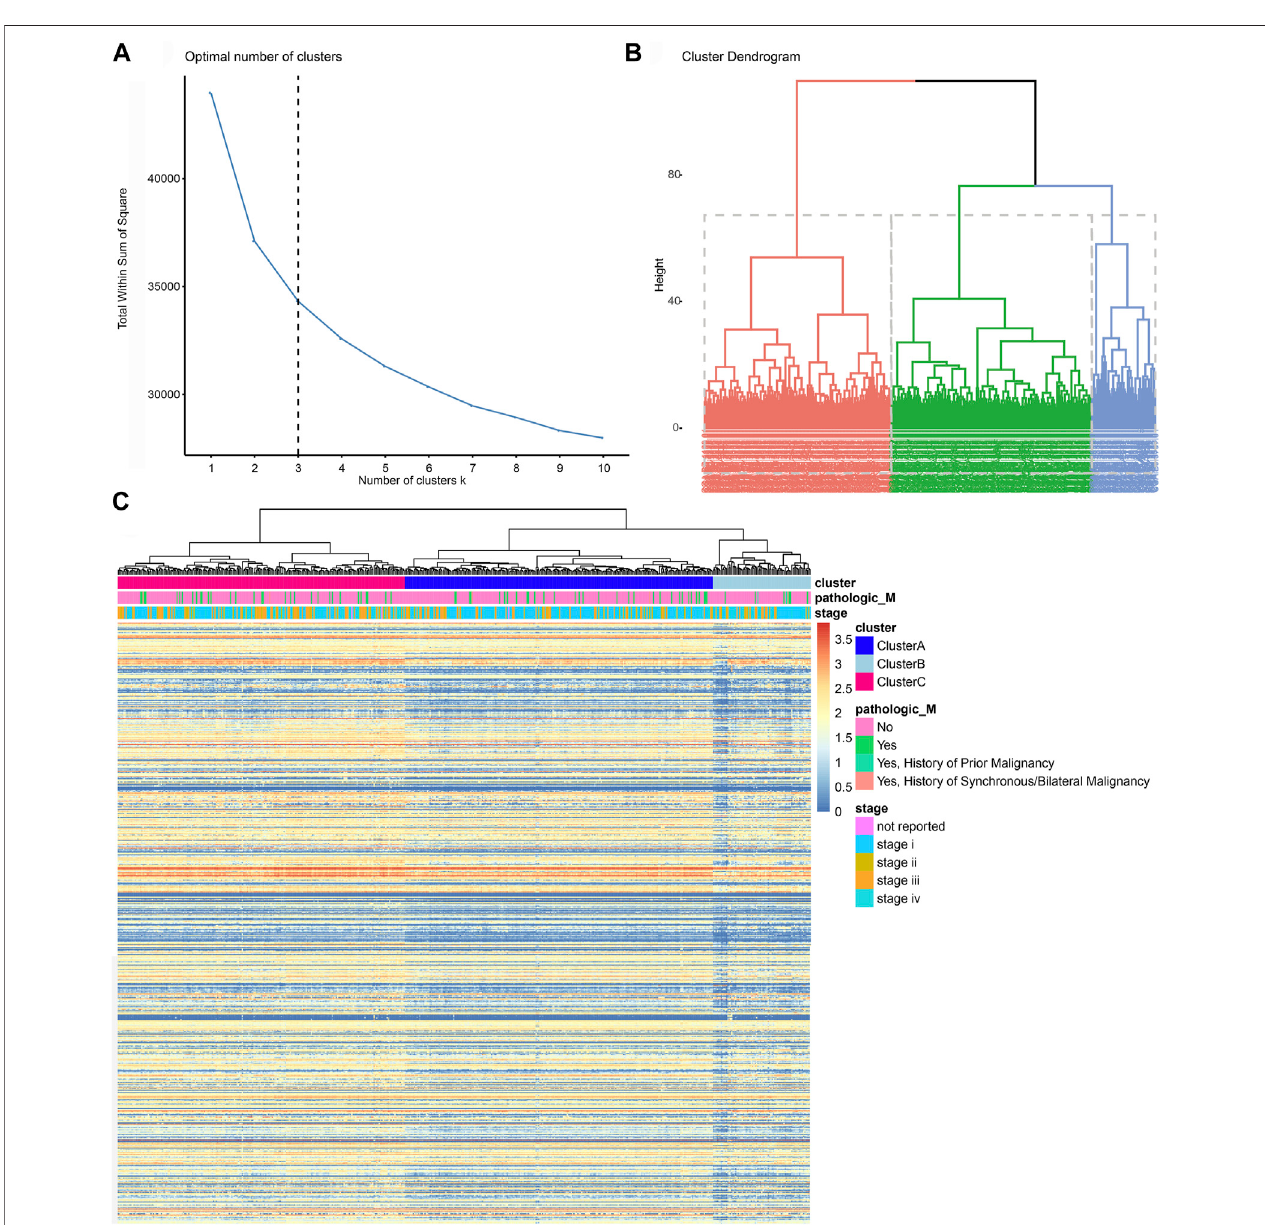
FIGURE2| Screeningandinitialconstructionofsubgroupsbasedon758immunegenes. (A,B) Hierarchicallyclusteringof758immunegenesfromthenCounter ®